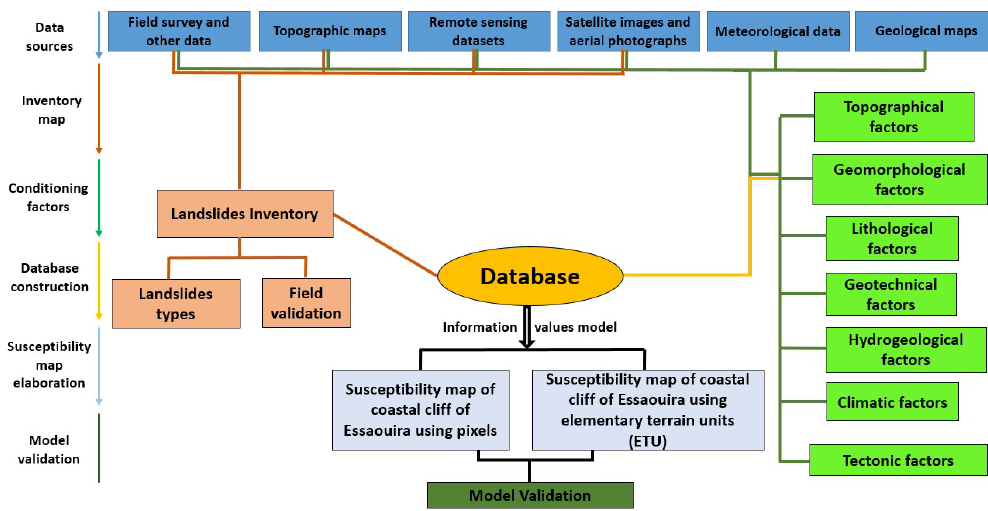
Figure 2. Schematic of the methodology